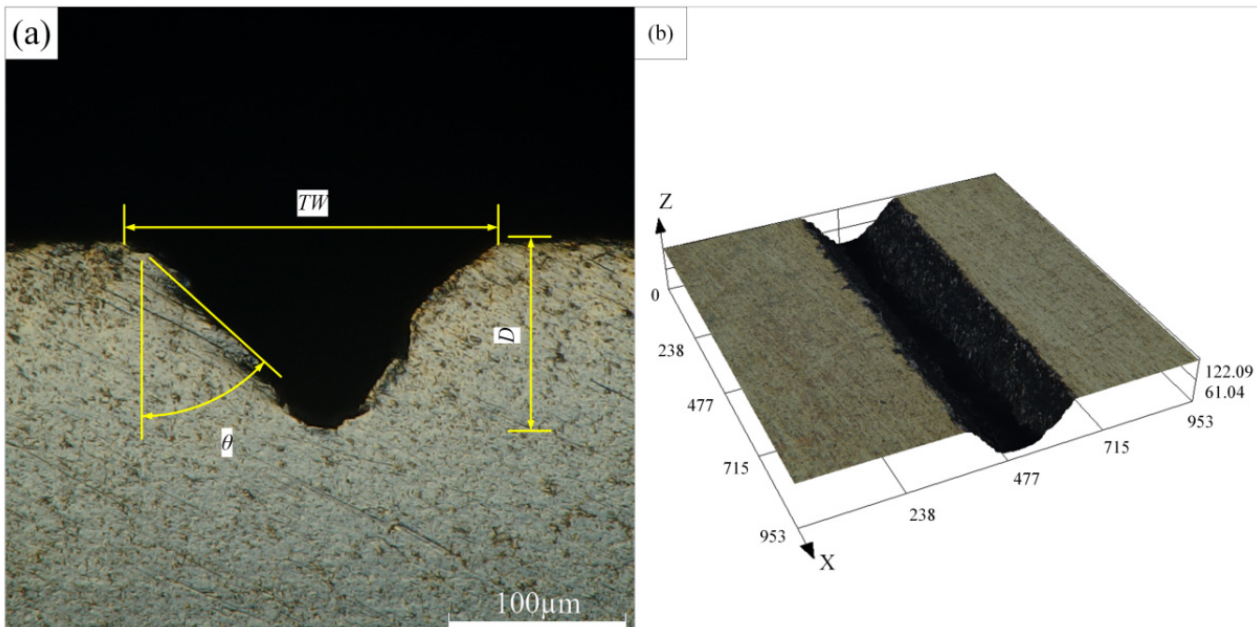
Figure 4. Schematic diagram of surface morphology of Ti-6Al-4V alloy microgroove. ( a ) Cross section of microgroove, ( b ) Three dimensional morphology of